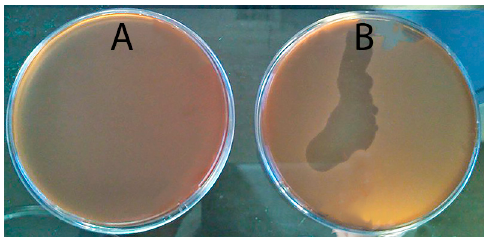
Figure 1. Spot test results using a phage-resistant mutant of phage AS-A and phage AS-A after first ( A ) and fifth streak-plating steps ( B ).